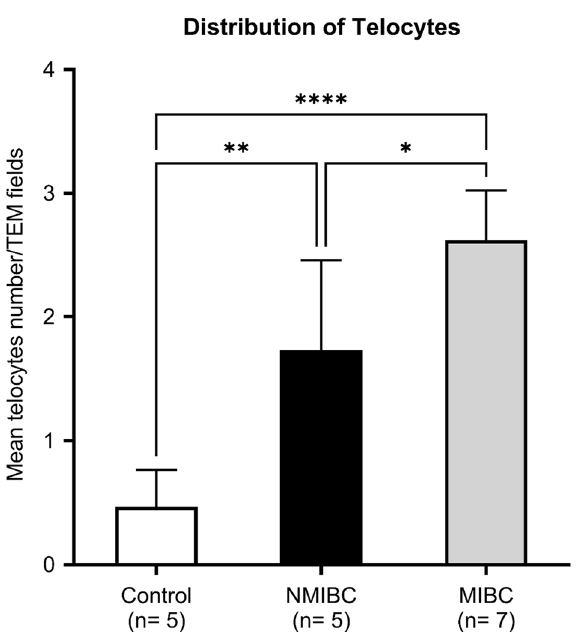
Figure 6. Relative quantitative distribution of TCs/TEM fields. Results are expressed as mean ± SD, **** p < 0.001, ** p < 0.01, * p <